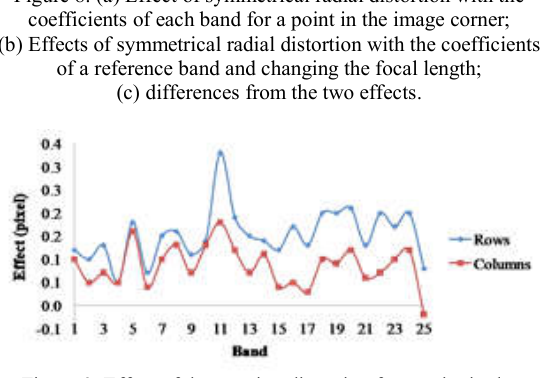
Figure 9. Effect of decentering distortion for a point in the image